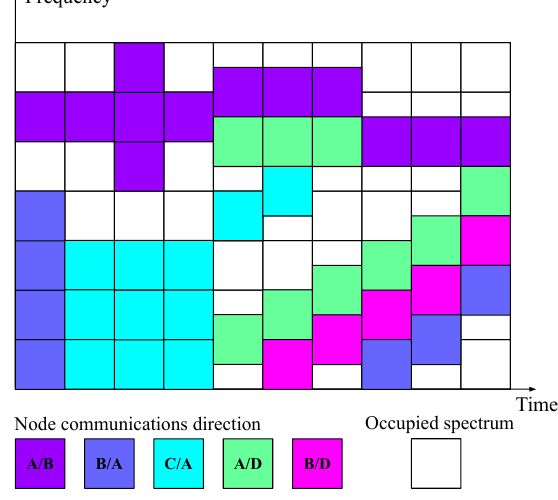
Figure 6. Snapshot of the spectrum usage in the TV